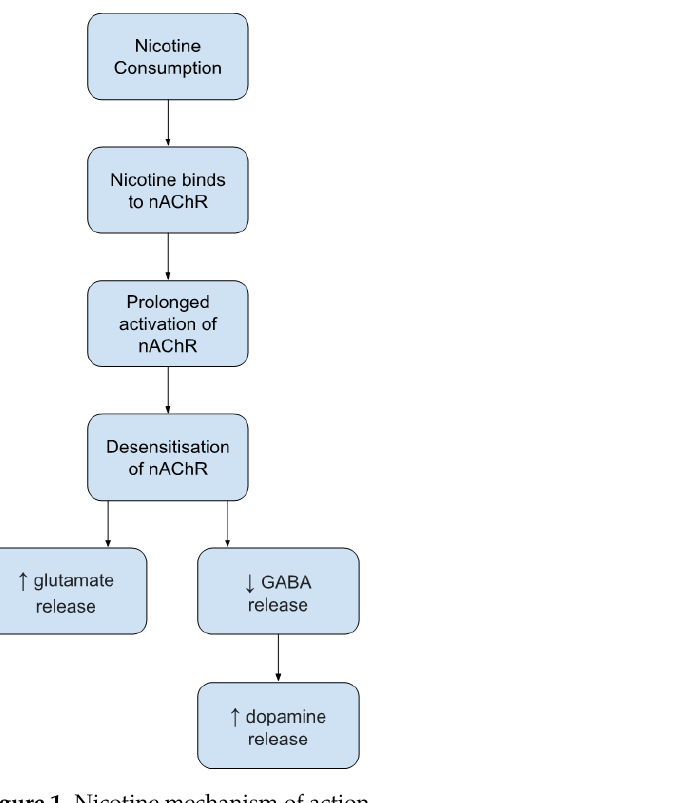
Figure 1. Nicotine mechanism of action.